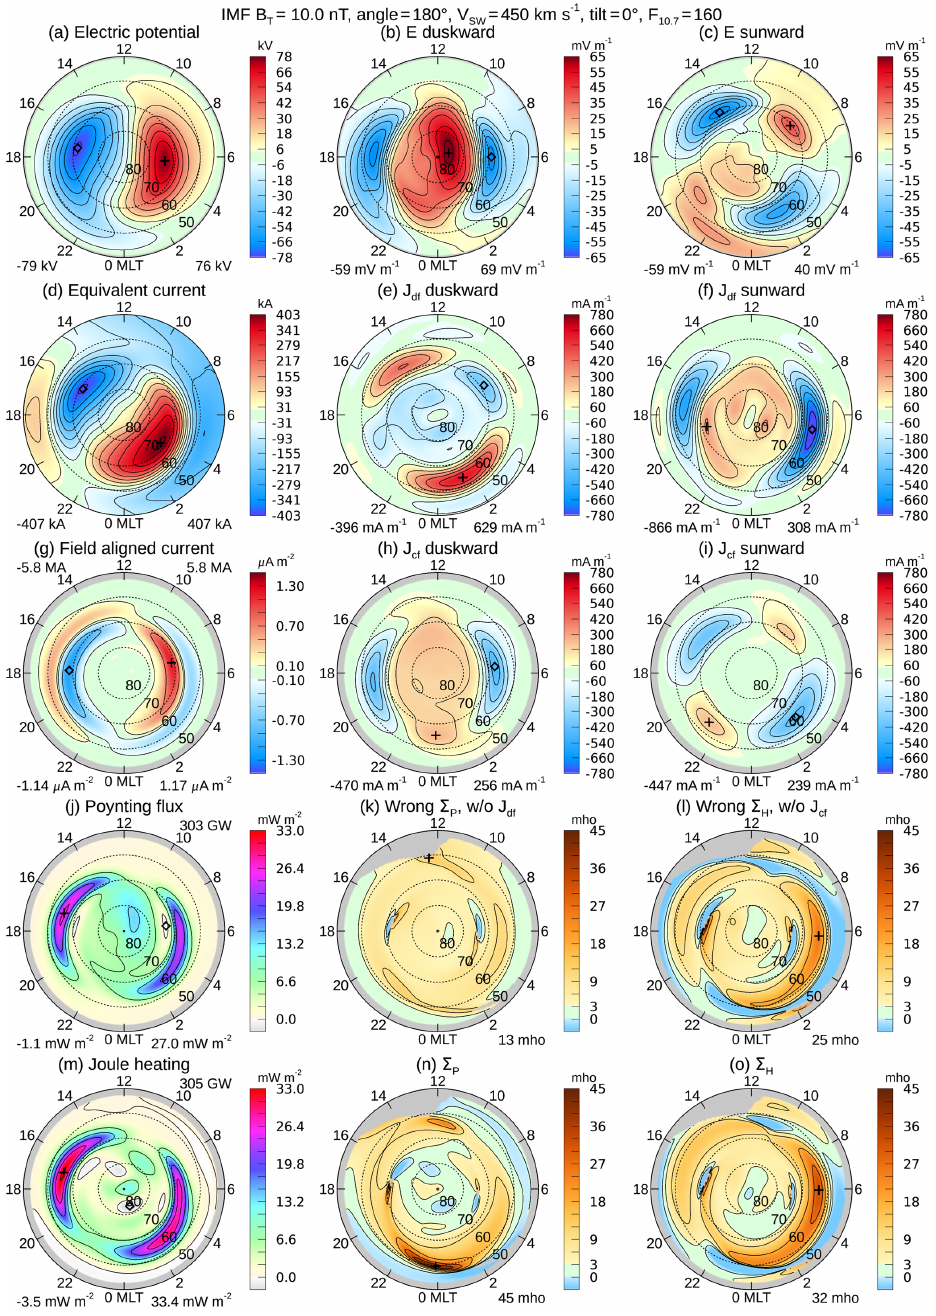
Figure 1. Conductivity input data and results for IMF B T magnitude 10nT at 180 ◦ clock angle. The solar wind velocity is 450km s − 1 ; the F 10 . 7 index is 160sfu; and the dipole tilt angle is 0 ◦ , corresponding to near equinox. Details are explained in the text.